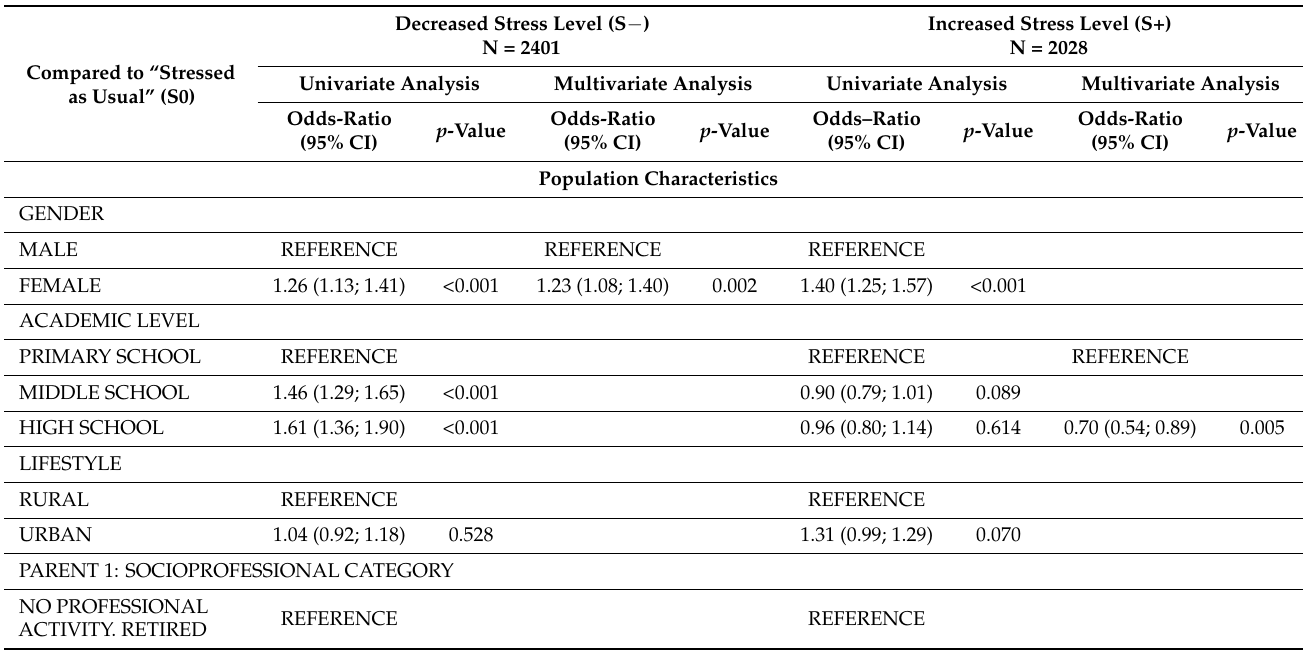
Table 1. Univariate and multivariate